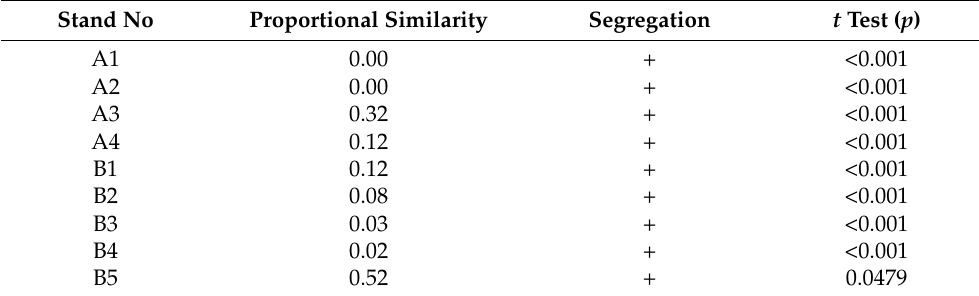
Table 3. Coefficient of proportional similarity for pine shoot beetles in different stem sections. Stand